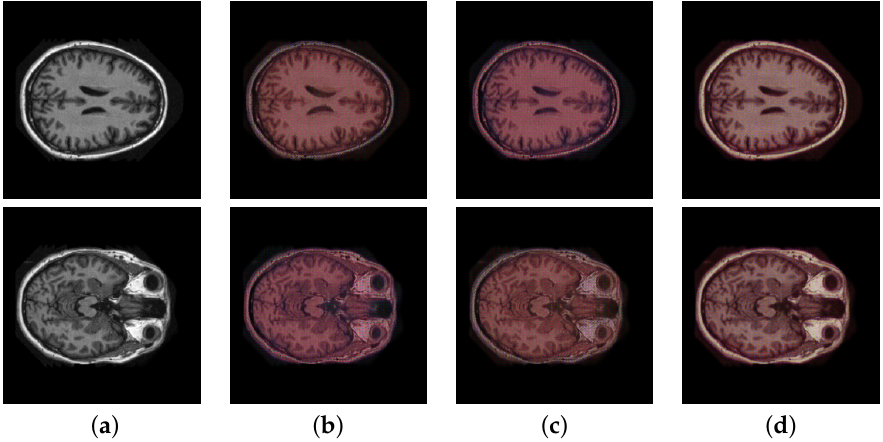
Figure 4. The feature map of two fusion modes. The left one presents the concatenate mode, the right one presents the sigmoid mode.